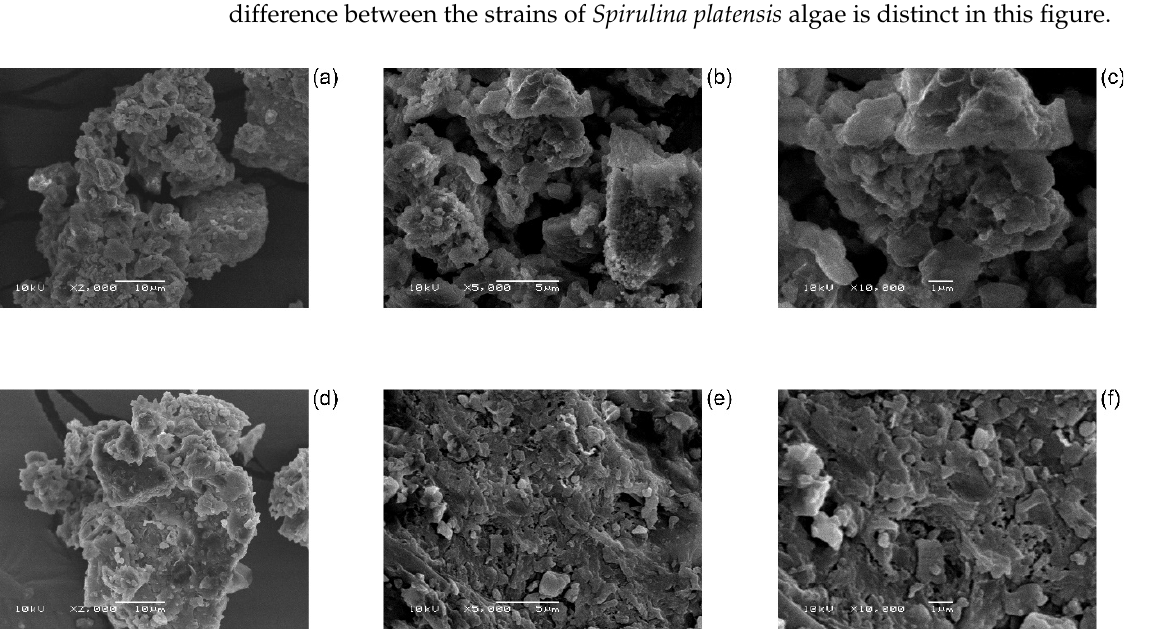
Figure 1. SEM images of LEB-18 ( a – c ) and LEB-52 ( d – f ) S. platensis . Augmentation factor 2000× ( a , d ), 5000× ( b , e ), and 10,000× ( c , f ).